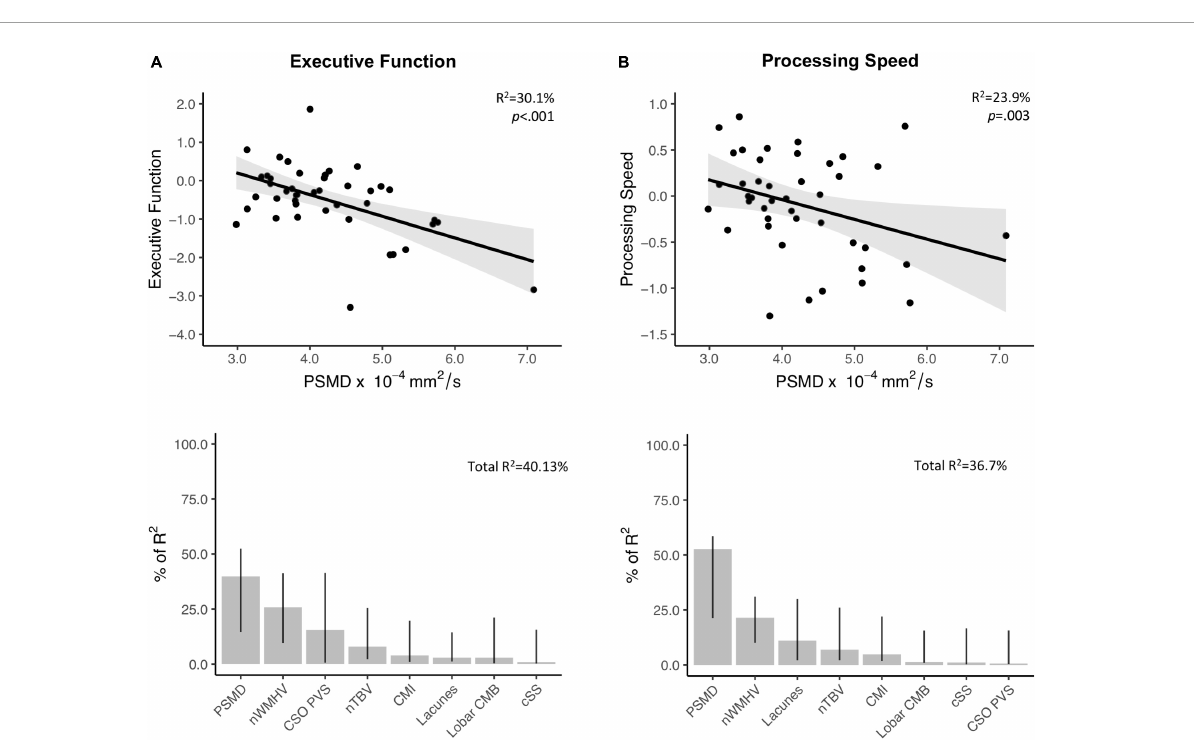
FIGURE3 Associations between PSMD and performance in executive function and processing speed. Upper panel: Results from simple linear regression models between PSMD values and executive function (A. Above) and processing speed (B. Above) in probable-CAA subjects. 95% confidence intervals are depicted in gray. The provided R 2 and p -values reflect the obtained independent predictive of PSMD with regards to cognitive scores adjusted for the interval between MRI and neuropsychological tests. Lower panel: Bar graphs representing the relative contribution of each neuroimaging marker to explaining the variance in executive (A. Below) and processing speed scores (B. Below) , using the LMG metric computed with the R package “Relaimpo”. Metrics are normalized to sum to 100%. Lines represent 95% confidence intervals after 1,000 bootstrapping